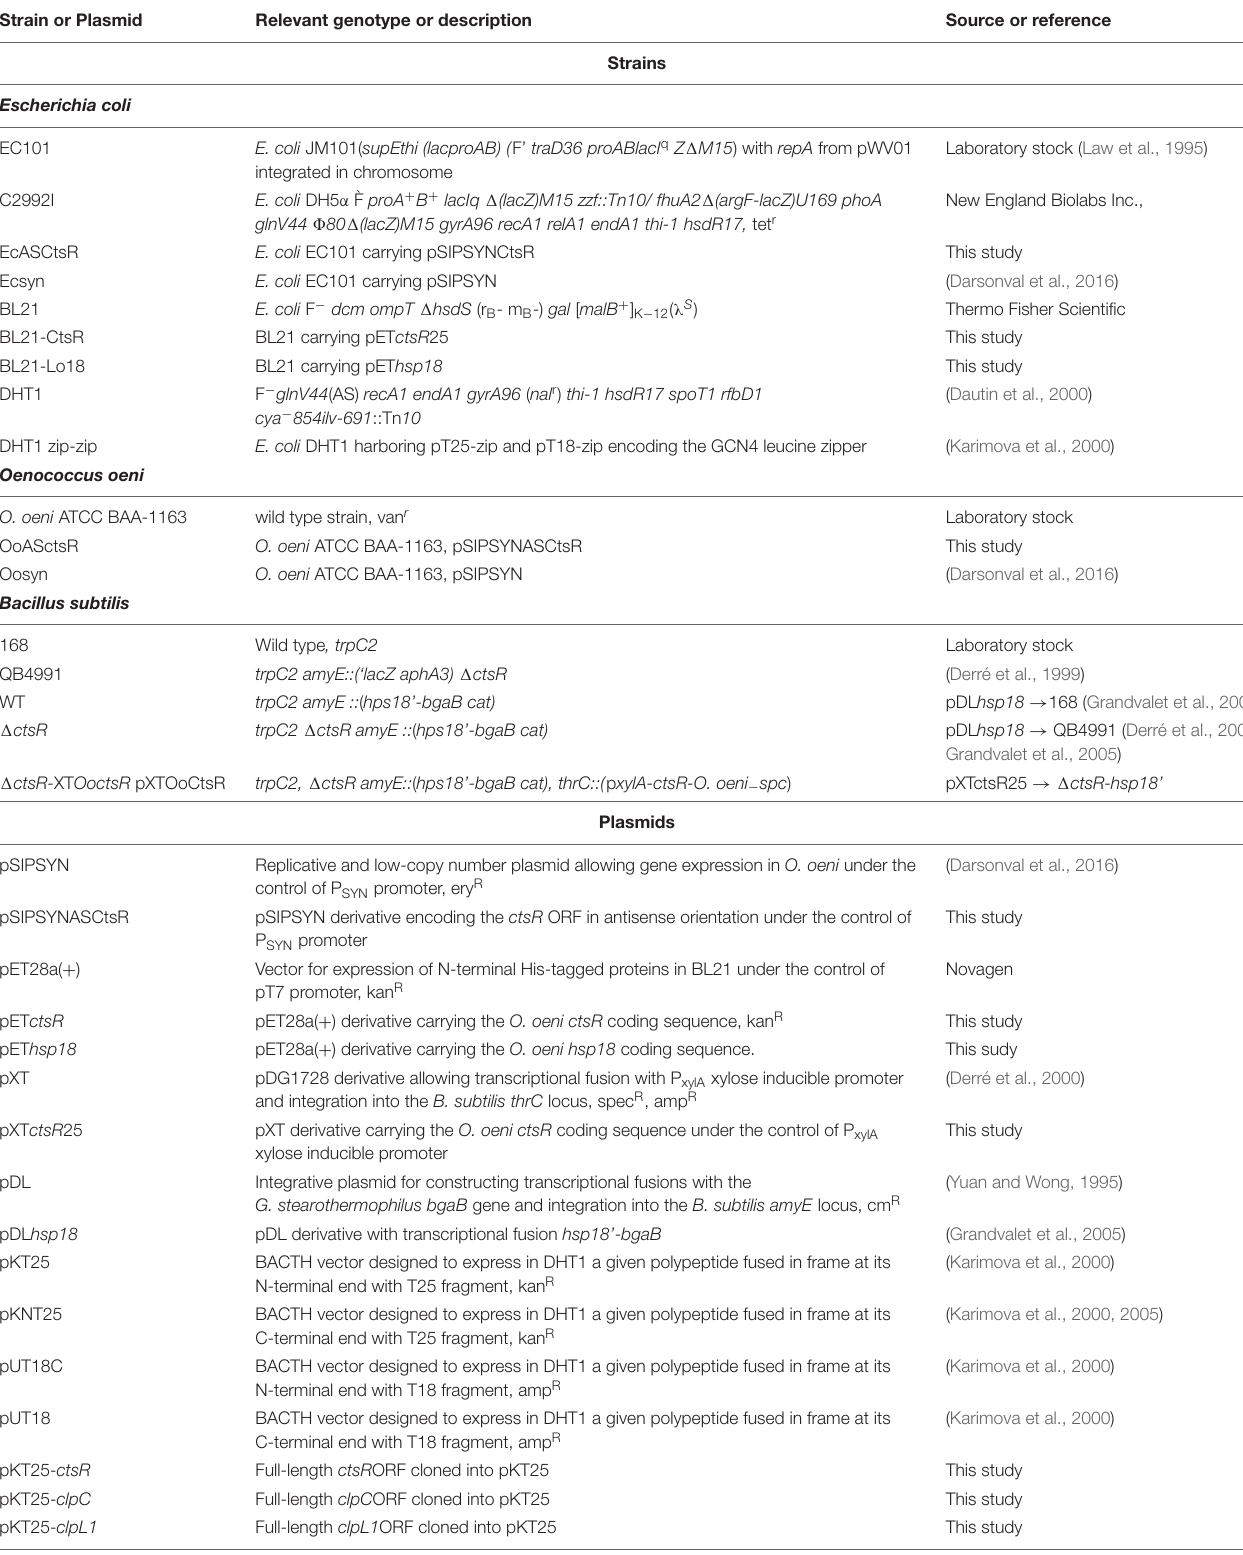
TABLE 1 | Bacterial strains or plasmids used in this